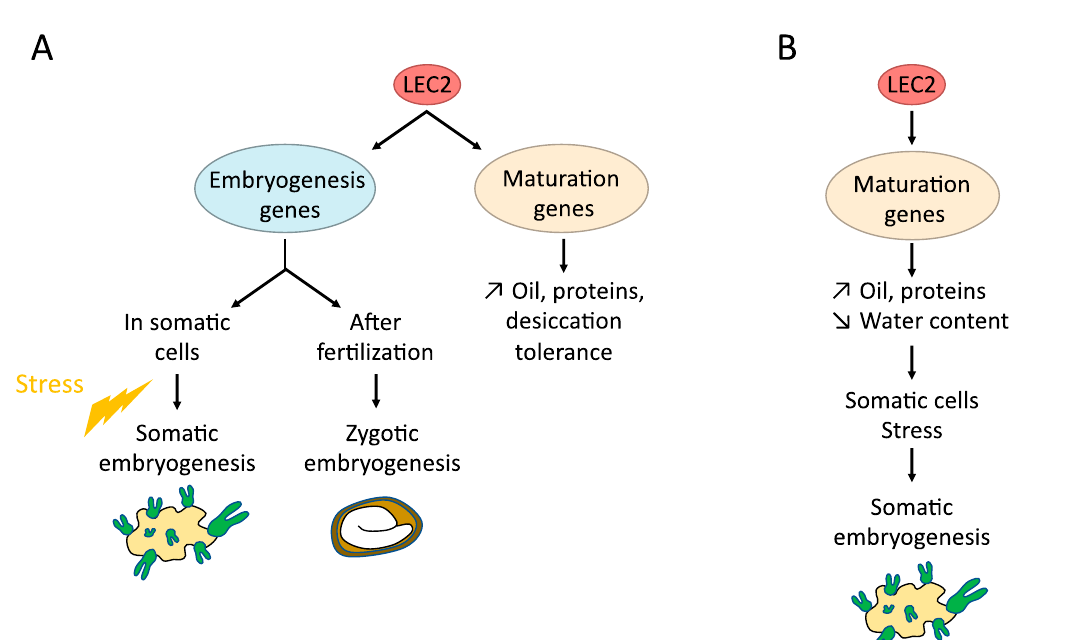
Figure 2. The possible roles of LEC2 in somatic embryogenesis. ( A ): LEC2 can have a dual function, one specific to embryogenesis, the other inducing maturation genes. The embryogenesis function may lead to SE or ZE depending on the type of cell it is expressed in, as well as possible stress and epigenetic modifications. ( B ): LEC2 induces stress through the accumulation of reserve specific compounds in the cells.